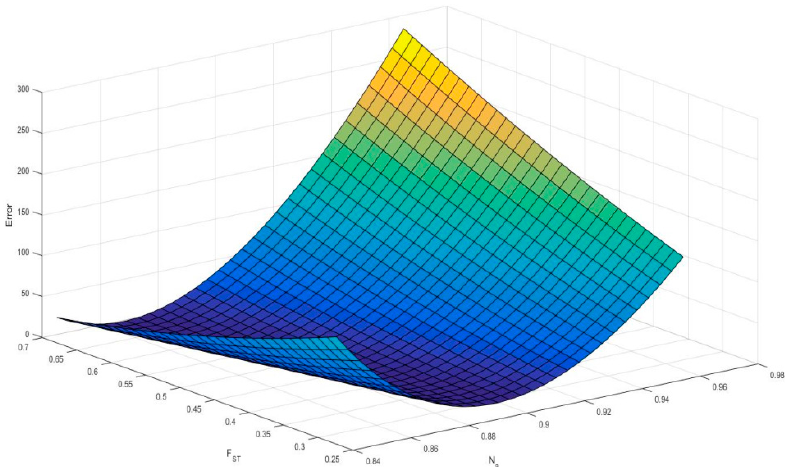
Figure 5. 3D plot of the fitness function against dry friction ( F ST ) and partial short circuit of phase A ( N a ). The blue valley has a constant fitness value, meaning that those two fault modes hide each other in the considered case.